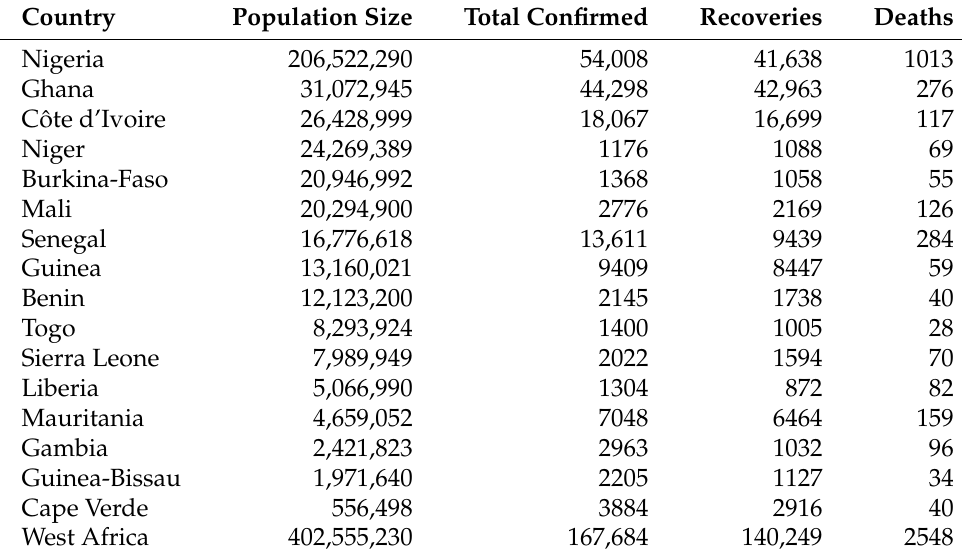
Table 1. Population size [28] and cumulative PCR-confirmed COVID-19 cases, deaths and